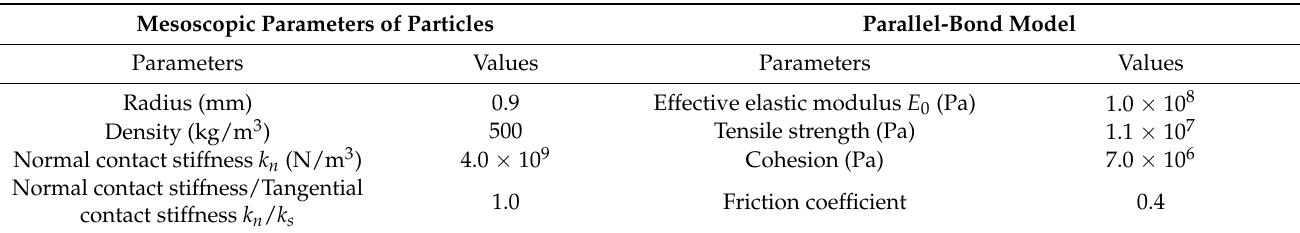
Table 2. Mesoscopic parameters of the parallel-bond model of foamed